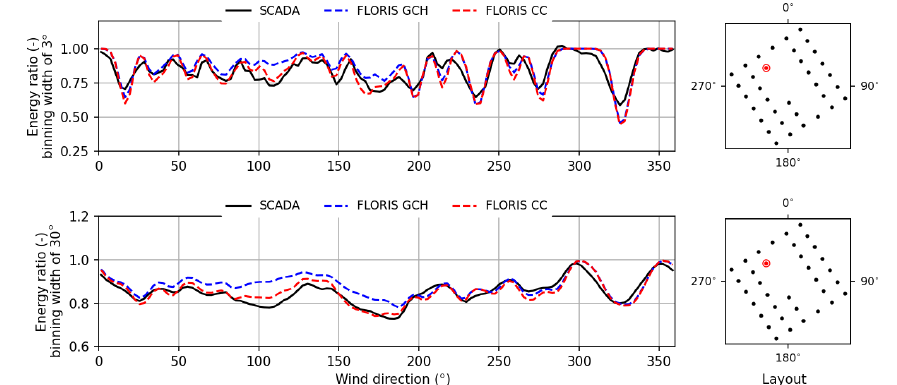
Figure 11. Energy ratio versus wind direction for Turbine 17, located in the northwest of the Westermost Rough wind farm. The reference turbines to which the energy ratio is normalized are the turbines that are both operating in freestream flow and within a 5km radius of Turbine 17. The reference wind direction is determined by the nacelle headings from turbines directly neighboring Turbine 17.